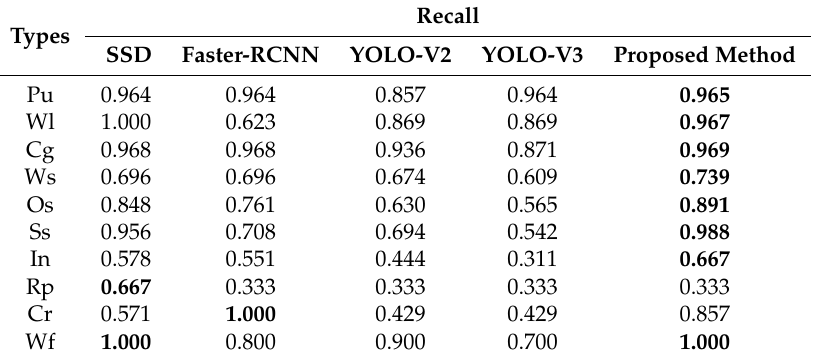
Figure 4. Detection results on NEU-DET dataset. In sequence, the pictures are: ( 1 ) Inclusion, ( 2 ) Crazing, ( 3 ) Patches, ( 4 ) Pitted surface, ( 5 ) Scratches, and ( 6 ) Rolled in scale. Table 4. Comparison of Recall on GC10-DET dataset. The proposed method performs the highest Recall values for seven defect categories. The bold helps to emphasize the highest